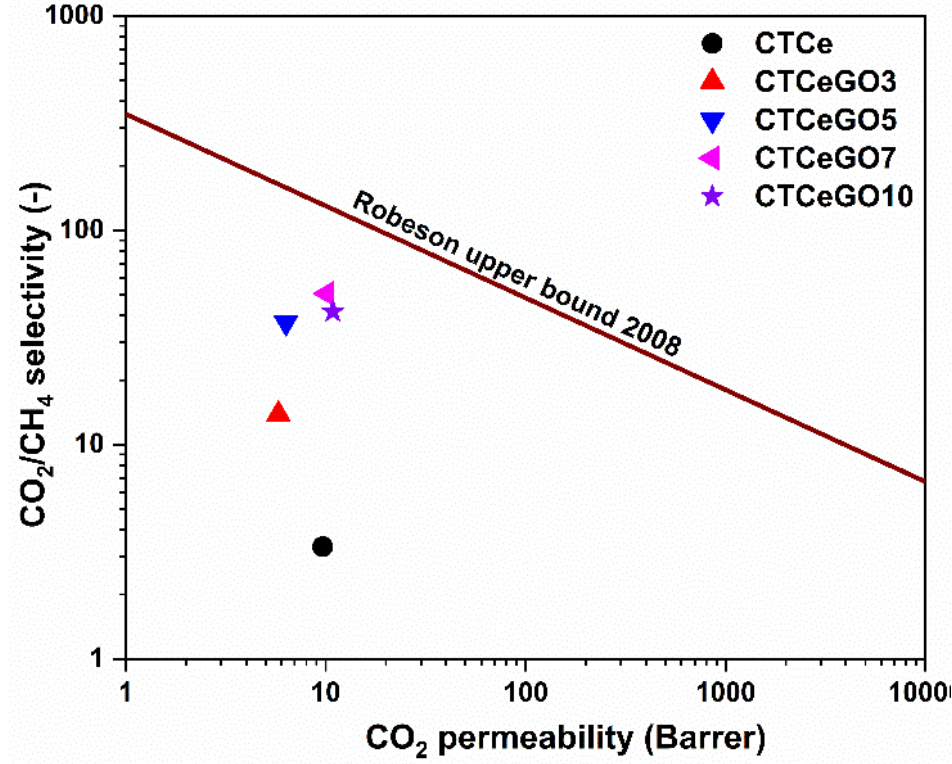
Figure 10. A comparison of CO 2 /CH 4 gas separation efficiency of studied MMMs with Robeson 2008 upper-bound plot [4].